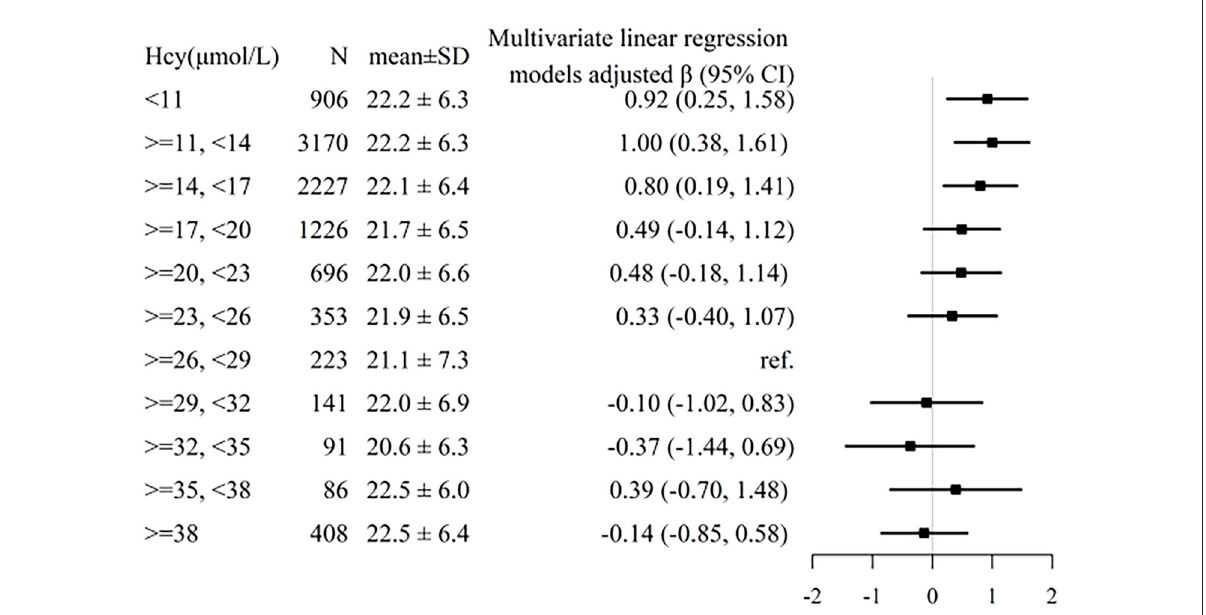
FIGURE2 Association between plasma tHcy levels and MMSE scores stratified by 3 µ mol/L intervals of tHcy concentrations. Individuals were divided into 3 µ mol/L intervals of tHcy concentrations. Adjustment factors included age, sex, education, BMI, smoking status, alcohol consumption, diabetes, CHD, antihypertensive drugs, SBP, DBP, total cholesterol, triglycerides, HDL-C, LDL-C, and